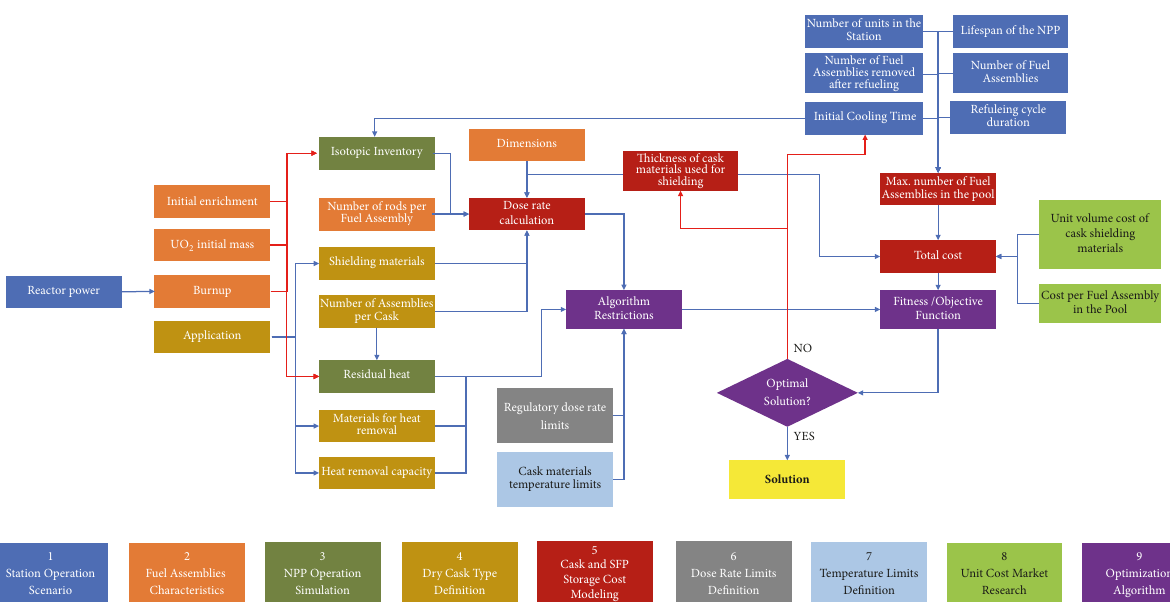
Figure 2: Flow graph of the steps involved in the proposed